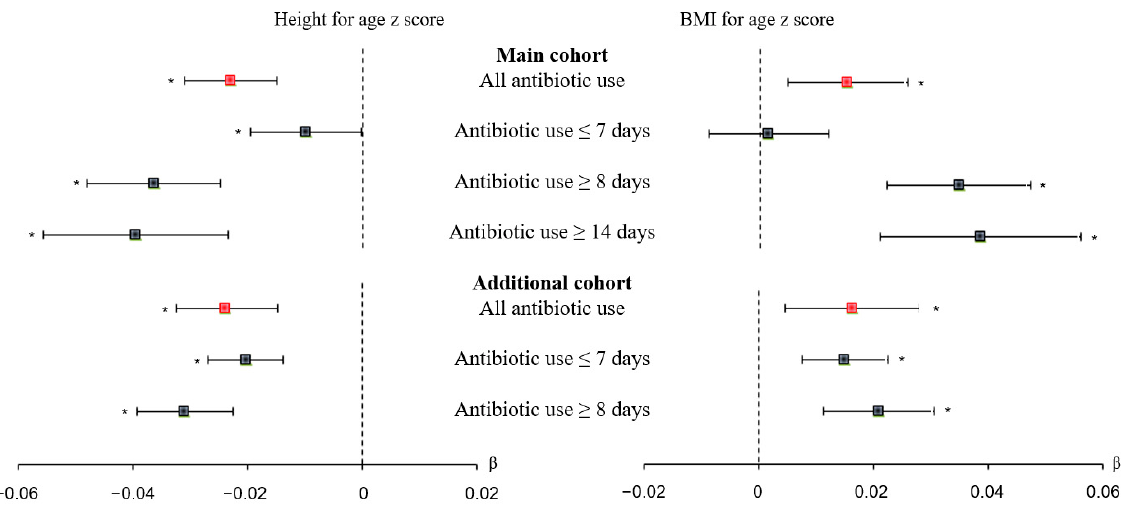
Figure 2. Effect of antibiotic use and duration of antibiotic use on linear growth (top) and ponderal growth (bottom) in the main cohort and in the additional cohort (forest plot). The main cohort and additional cohort consisted of participants who were antibiotic users or non-users within 6 months after birth and within 3 months after birth, respectively. Black filled rectangles indicate β , black lines indicate 95% CIs, and asterisks indicate p < 0.05.